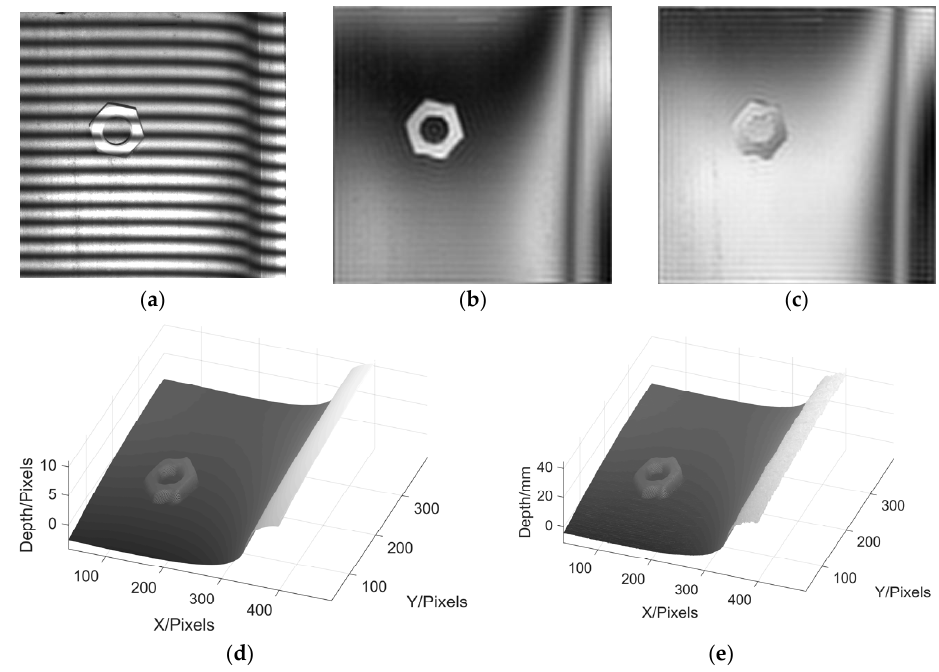
Figure 15. Experimental reconstruction results of wheel tread with a nut. ( a ) deformed fringe; ( b ) moire fringe pattern 1; ( c ) moire fringe pattern 2; ( d ) phase reconstruction; ( e ) height reconstruction.